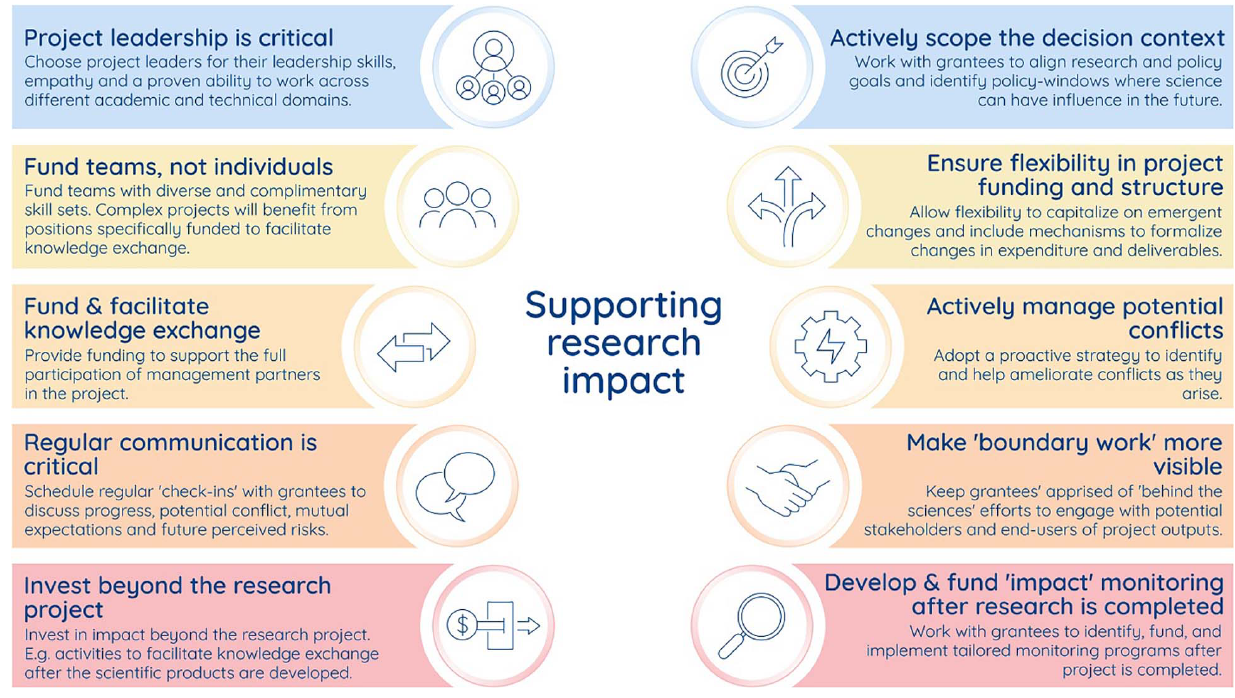
FIGURE 1 | Ten considerations for research funders seeking to enhance the impact of marine science on policy and